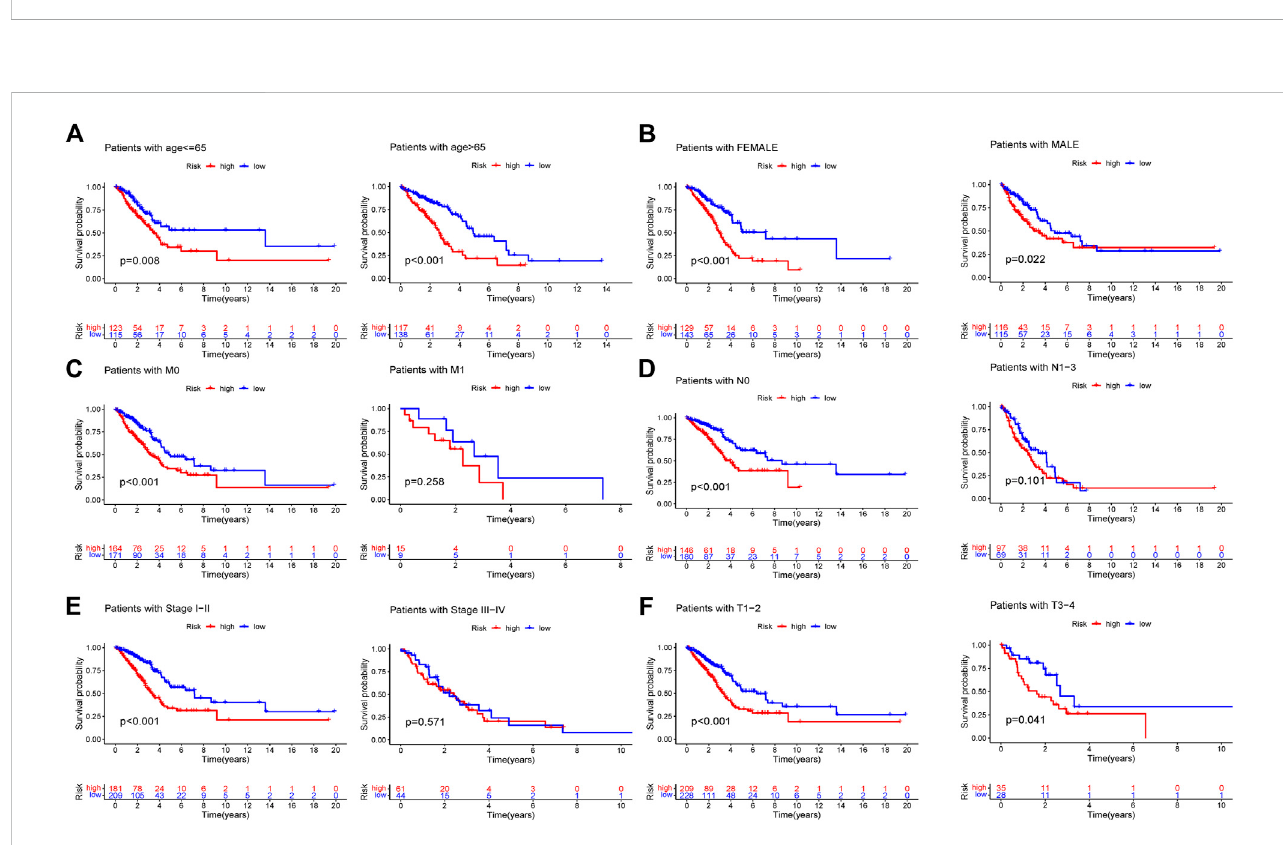
FIGURE 7 SubgroupstudyofvariousclinicalcharacteristicsusingtheRSformula. (A) Age > 65 yearsandage ≤ 65 years. (B) FEMALEandMALE. (C) M0andM1. (D) NO and N1-3. (E) Stage I-II and stage III-IV. (F) T1-2 and T